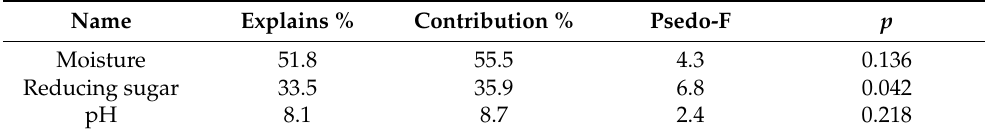
Figure 10. The initial formation of the Daqu surface during fermentation. ( A ) The results of partial least squares regression between the Daqu surface and Daqu core in the fourth stage during fermentation. ( B ) Redundant analysis of the fungi and physical and chemical parameters in the fourth stage. *: p < 0.05 and **: p < 0.01. Table 4. The relationship between the fungal community and physicochemicals in the fourth stage.